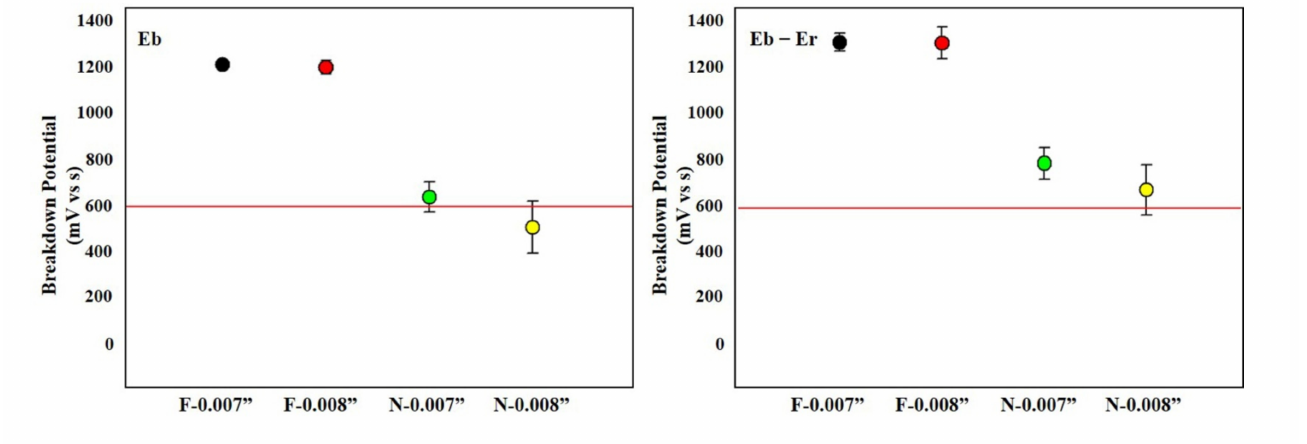
Figure 1. Cyclic potentiodynamic values of Furukawa and NDC wires without any treatment. Red lines indicate acceptance criteria in this study as mentioned in Materials and Methods section. ‘F’ and ‘N’ are acronyms for ‘Furukawa’ and ‘NDC’,